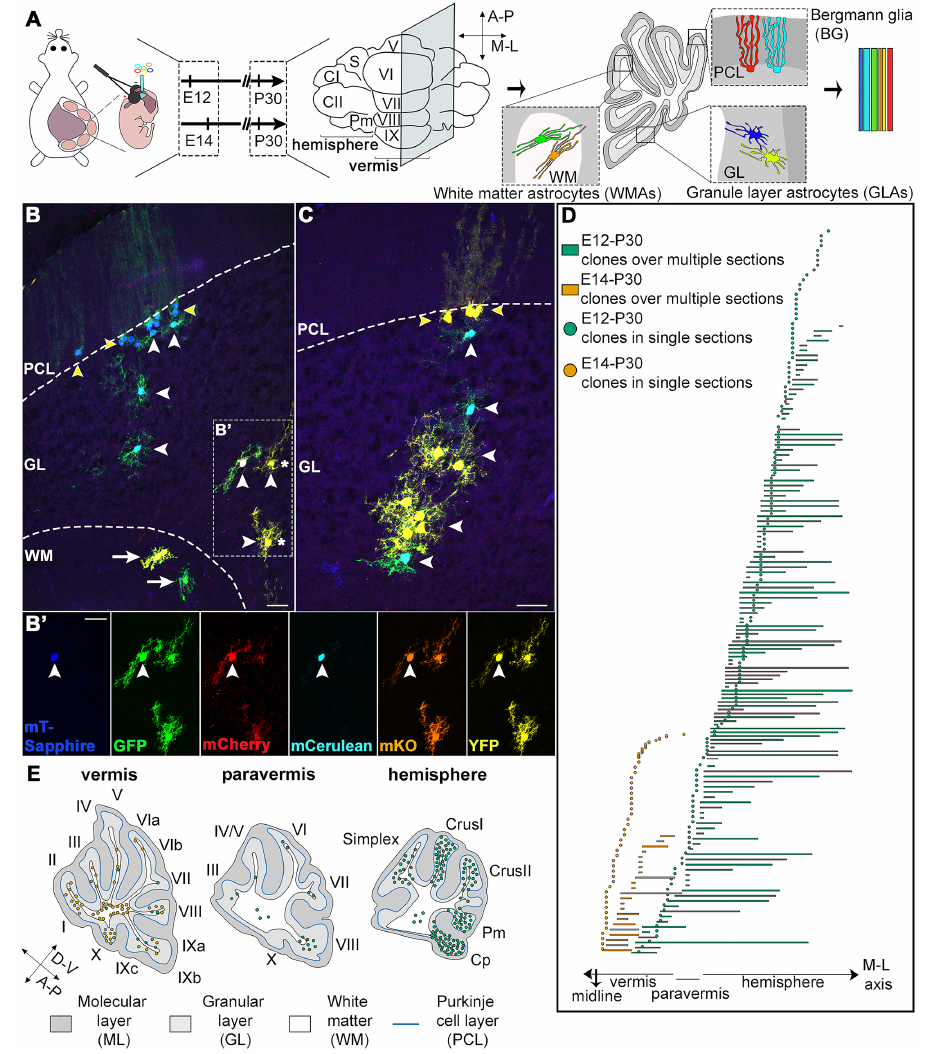
Fig 1. In utero StarTrack electroporations and clone allocation in the cerebellum. (A) Schematic representation of the experimental design. The hGFAP-StarTrack mixture was electroporated at E12 or E14, and clonal analysis was performed at P30. (B,C) StarTrack-labeled astrocytes are found in all cerebellar layers in P30 mice and comprise WMAs (white arrows), GLAs (white arrowheads), and BG (yellow arrowheads). In B’, 2 sister GLAs share the same combination of fluorescent proteins (asterisks), whereas the third GLA displays a different color combination, thus deriving from a different progenitor, even though it is very close to the other 2 GLAs. (D) Schematic representation of the relative M-L extension of each clone. E12-P30 clones (green) preferentially settle in the cerebellar hemispheres, whereas E14-P30 families (orange) are exclusively located in the vermis. Based on the cerebellar symmetry around the midline, all clones are projected on one-half cerebellum. The paravermis is defined as that region where lobule IX fades and lobule X is still present. (E) Diagrams are representative of clone distribution along the A-P axis. E12-P30 clones (green) are homogeneously distributed in all lobules of the hemispheres, whereas E14-P30 ones (orange) preferentially occupy the ventral vermis, including both anterior and posterior folia. Each dot corresponds to 1–2 clones. When clones are found in > 1 lobule, they are repeatedly represented in each corresponding folium. Scale bars: 30 μm. A-P, antero-posterior; BG, Bergmann glia; CI and CII, CrusI and CrusII; Cp, copula pyramidis; D-V, dorso-ventral; E, embryonic day; GFP, green fluorescent protein; GLA, granular layer astrocyte; hGFAP, human glial fibrillary acidic protein; mCerulean, monomeric Cerulean; mCherry, monomeric Cherry; mKO, mKusabira Orange; M-L, medio- lateral; mT-Sapphire, monomeric T-Sapphire; P, postnatal day; PCL, Purkinje cell layer; Pm, paramedian; S, Simplex; WM, white matter; WMA, white matter astrocyte; YFP, yellow fluorescent